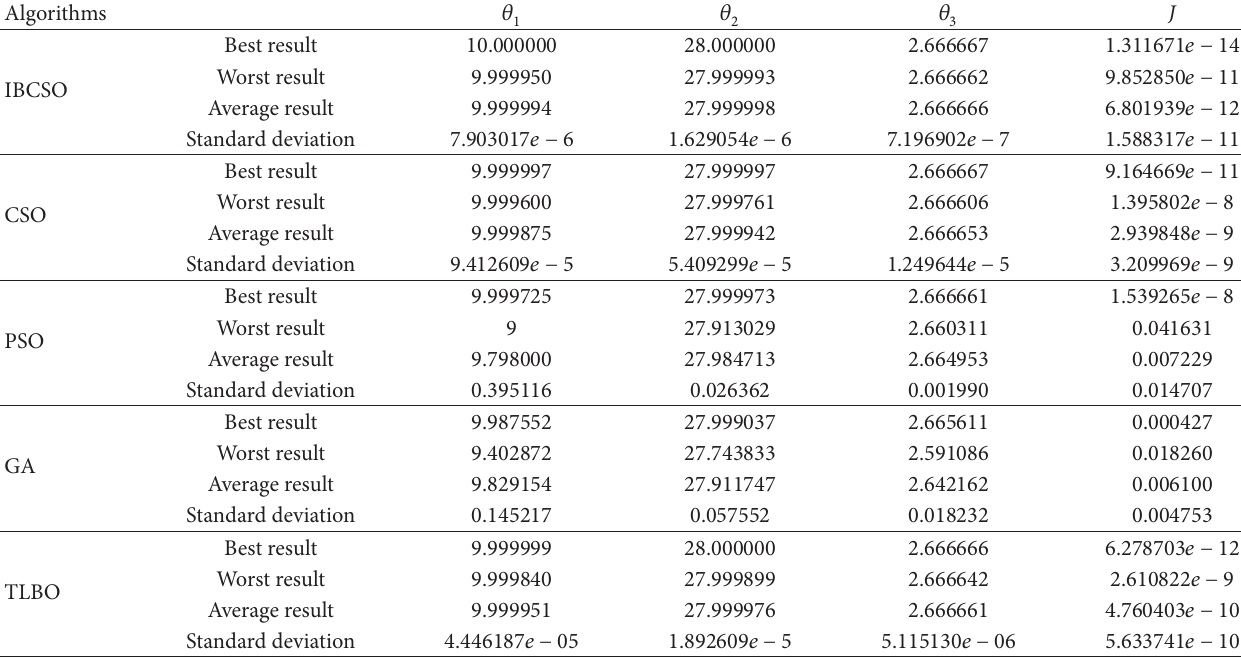
Table 2: Statistical results from the IBCSO, CSO, PSO, GA, and